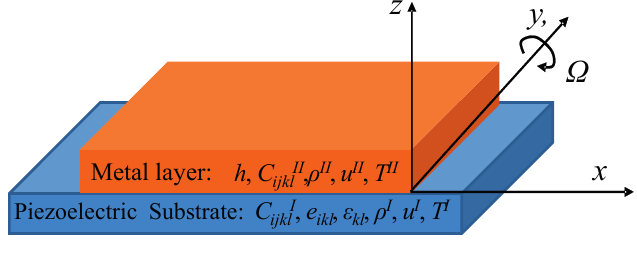
Figure 2. The coordinate system used in this